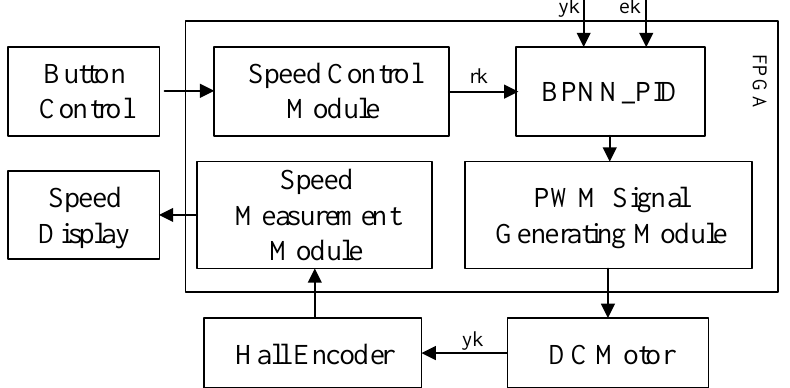
Figure 15. DC motor control system measurement and control module structure diagram.